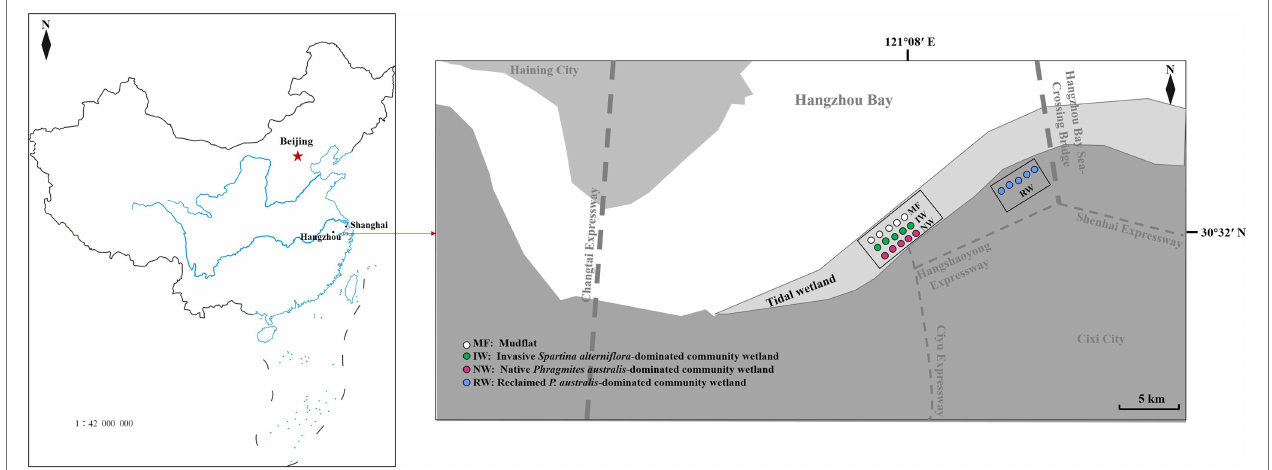
FIGURE 1 | The location of the study area. MF, mudflat; NW, native Phragmites australis -dominated community wetland; IW, invasive Spartina alterniflora - dominated community wetland; and RW, reclaimed P. australis -dominated community